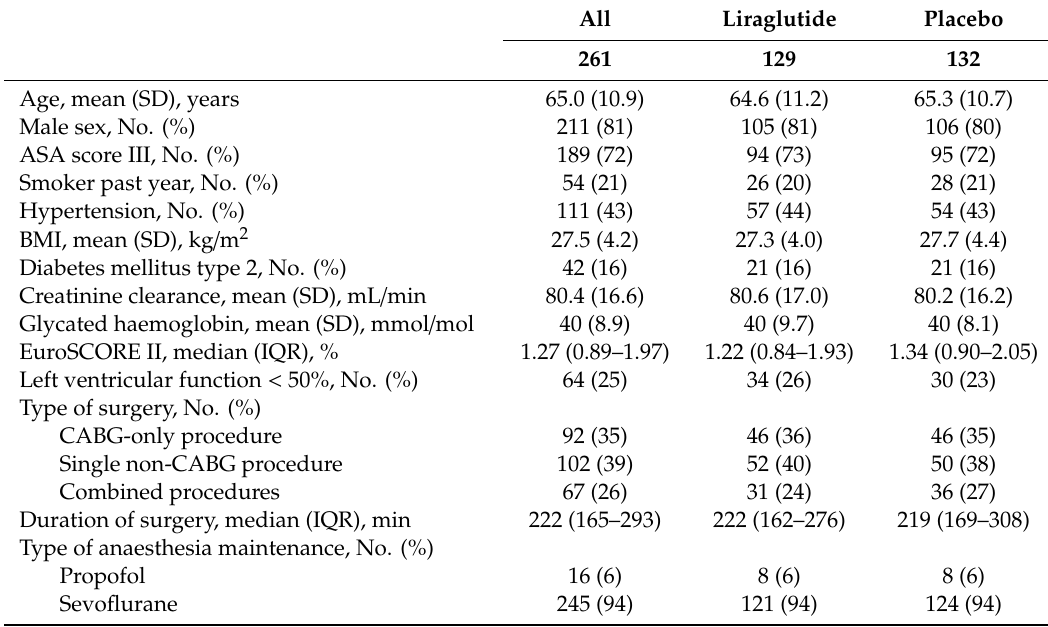
Table 1. Baseline characteristics of the intention-to-treat